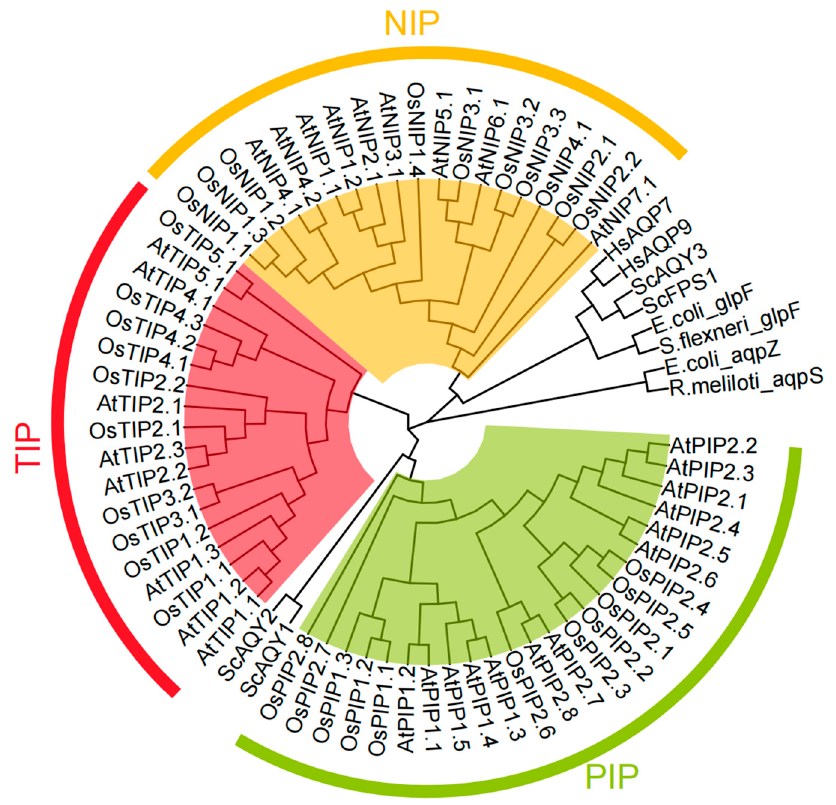
Figure 2. The phylogenetic tree of aquaporins from E. coli , S. flexneri , R. meliloti , S. cerevisiae , A. thaliana , O. sativa , and H. sapiens . Alignment of the amino acid sequences of aquaporins was made by Clustal W software using default parameters. The phylogenetic tree was made using MEGA X software by the Maximum Likelihood method, with 1000 Bootstrap replicates. The tree was finalized using the R software ggtree package. Different colors of arcs indicate different subfamilies. The accession numbers of the proteins are shown in Supplementary Table S2.